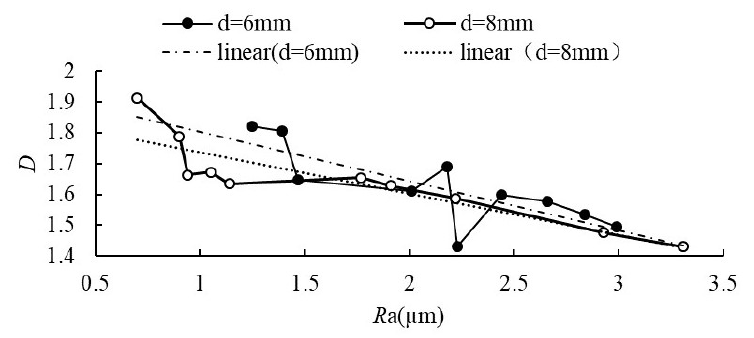
Figure 8. Relationship between R a and D .